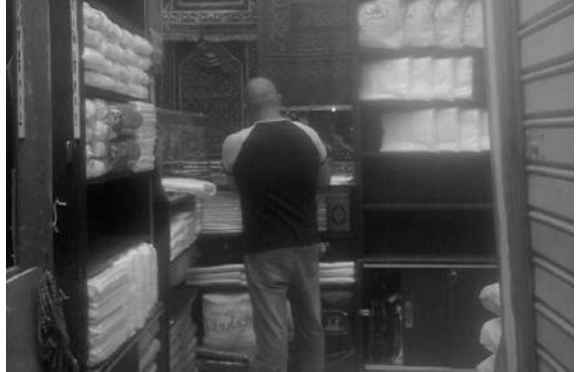
Figure 16. Vendor's